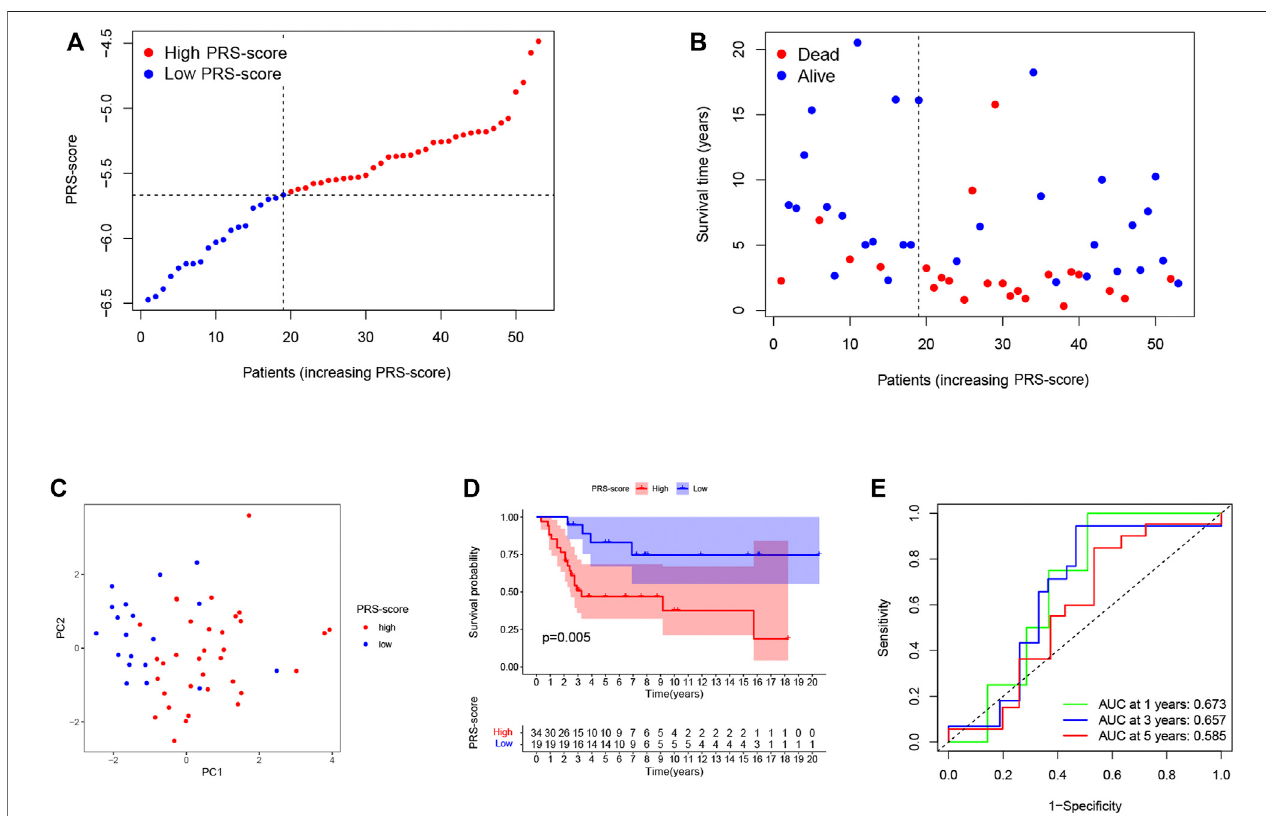
FIGURE 5| Validation ofthe prognostic signature in the GEO cohort. (A) The PRS-scoredistribution ofthe patientswithosteosarcoma in the GEO cohort. (B) The survival status and survival time distribution of the patients with osteosarcoma in the GEO cohort. (C) PCA plot based on the PRS-scores in the GEO cohort. (D) Kaplan – MeiercurvesofthehighandlowPRS-scoresubgroupsintheGEOcohort. (E) Time-dependentROCcurveforpredicting1-,3-,and5-yearoverallsurvivalinthe GEO cohort.